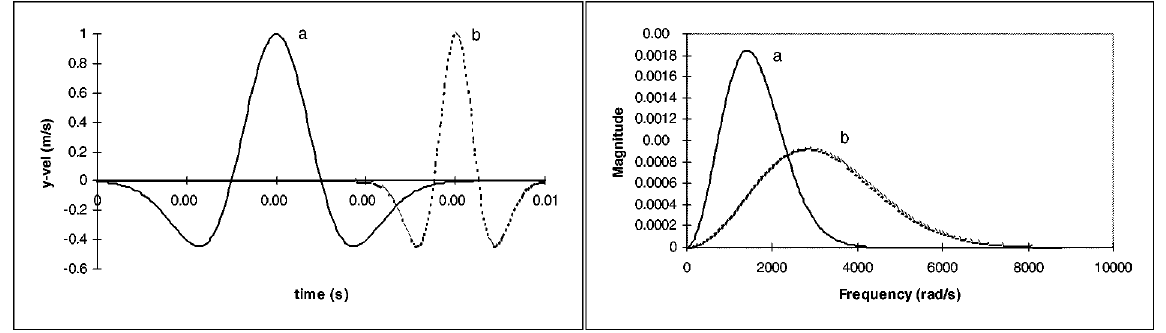
Fig. 1. The Mexican hat wavelet for two dilations and locations and, right, their